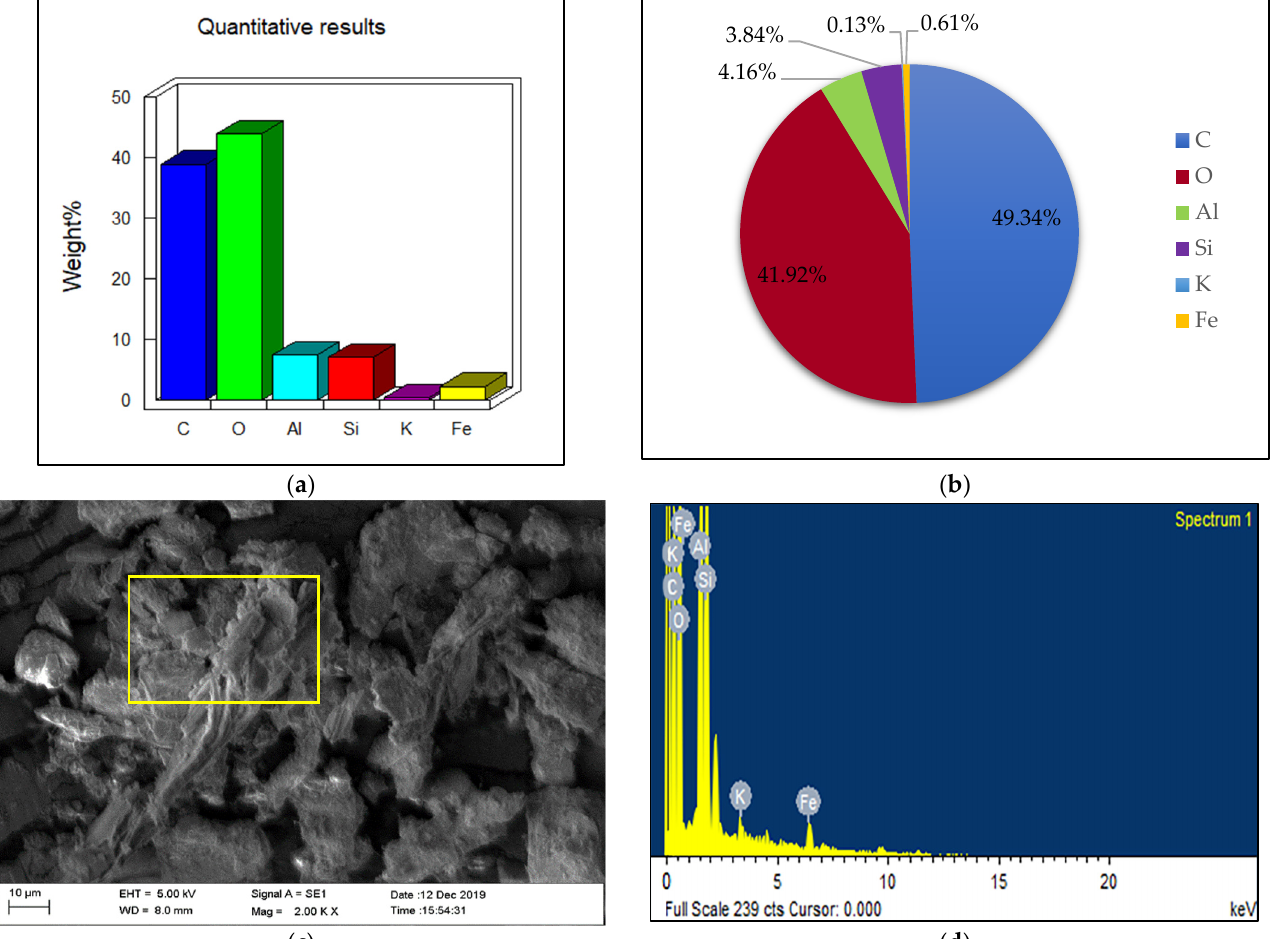
Figure 15. EDS analysis of Hemmadi sample; ( a ) elements weight (%), ( b ) atomic weight (%), ( c ) SEM image, ( d ) spectrum image.